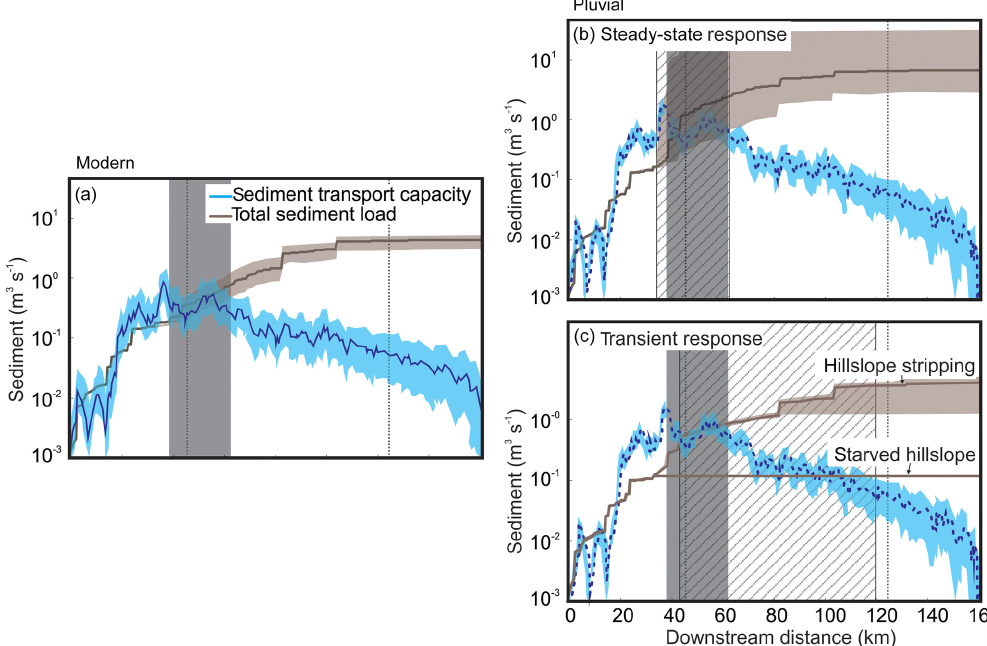
Figure 10. Model of hillslope erosion through (a) steady-state erosion and (b) transient hillslope stripping. In each graph, the solid grey area indicates the range of the modern bedrock–alluvial transition. The cross-hatched area indicates the endmember locations of the bedrock– alluvial transitions for each scenario. The grey stippled lines indicate the location of the Pisco river terraces. In the steady-state case, the sediment load, Q s , is proportional to the aerially summed upstream denudation rate, D , even if there is a thick regolith mantle (h) . The result is a minimal shift in the bedrock–alluvial transition (the point at which sediment load exceeds sediment transport capacity; Tucker and Slingerland, 1997) between wet and dry phases (b) . In the transient case, the entire modelled soil mantle (after Norton et al., 2014) is stripped during a wet phase such that the sediment load, Q s , is proportional to the aerially summed upstream regolith mantle, H , followed by a lack of sediment during the starved phase. The modelled result is a significant downstream shift in the bedrock–alluvial transition (c) , which roughly corresponds to the observed occurrence of terraces in the Pisco